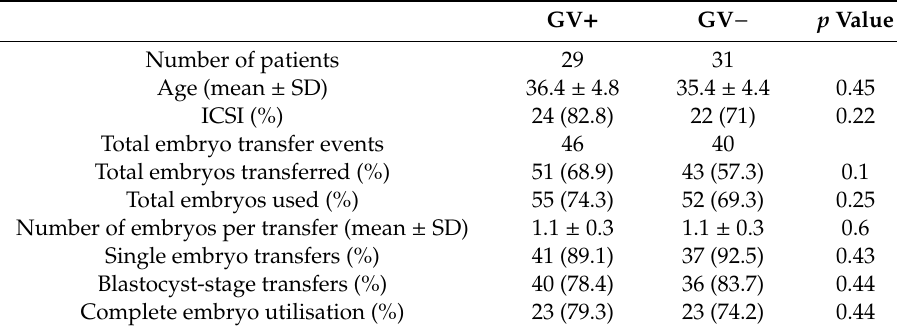
Table 1. Patient and treatment cycle